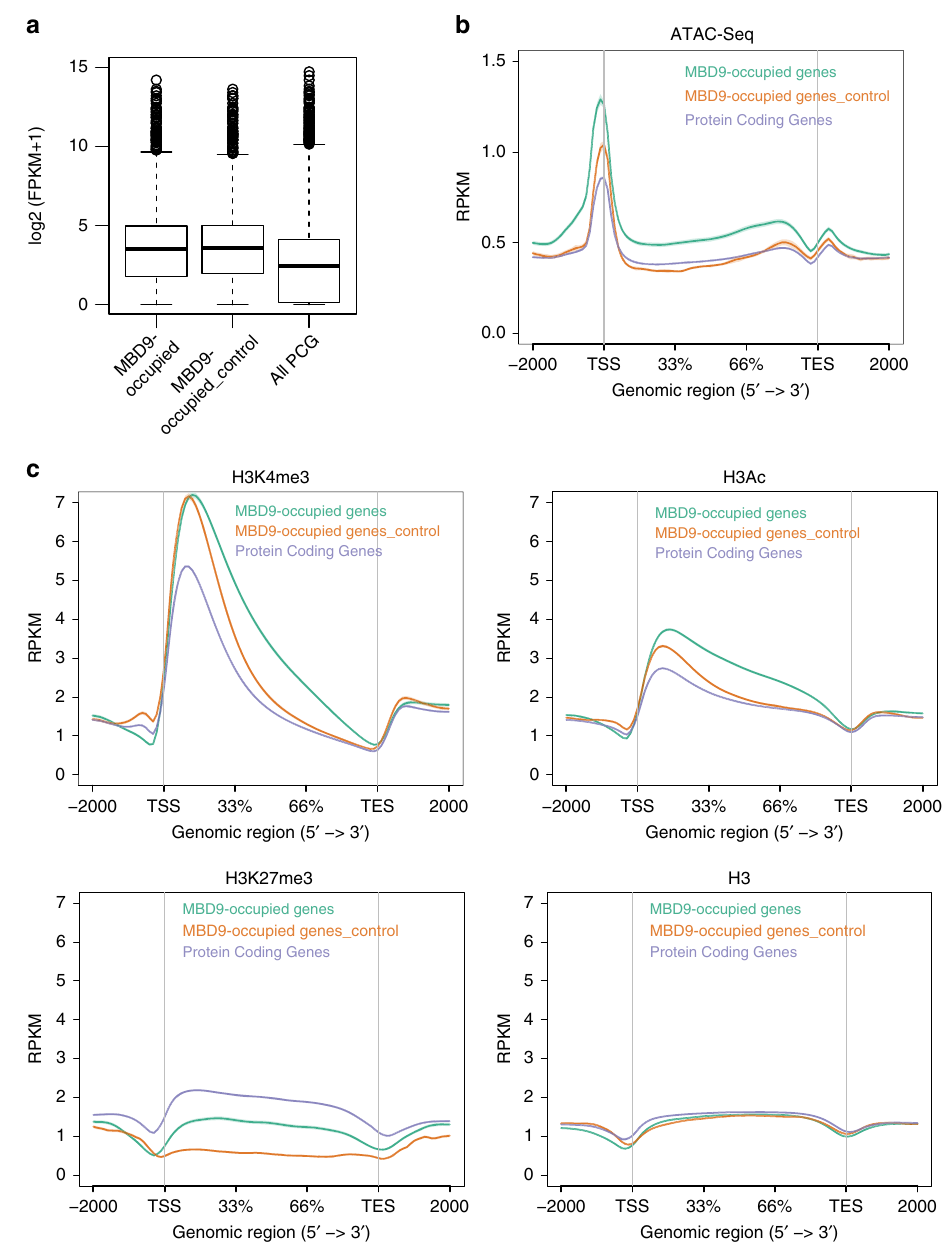
Fig. 5 Chromatin features at MBD9-occupied genes. a Boxplots of average expression levels log 2 (FPKM + 1) from RNA-seq in wild type for MBD9- occupied genes, MBD9 control genes, and protein-coding genes. Center line indicates the median, upper and lower bounds represent the 75th and the 25th percentile, respectively, whiskers indicate the minimum and the maximum, and outliers are represented as circles. b Distribution of normalized ATAC-seq levels (RPKM) over MBD9-occupied genes, MBD9 control genes, and protein-coding genes. c Distribution of normalized levels (RPKM) for H3K4me3, H3Ac, H3K27me3, and H3 ChIP-seq in MBD9-occupied genes, MBD9 control genes, and protein-coding